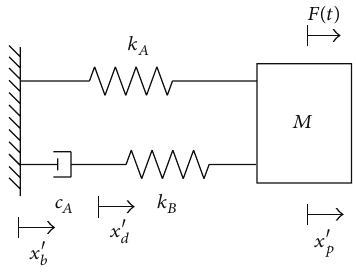
Figure 17: Three-parameter